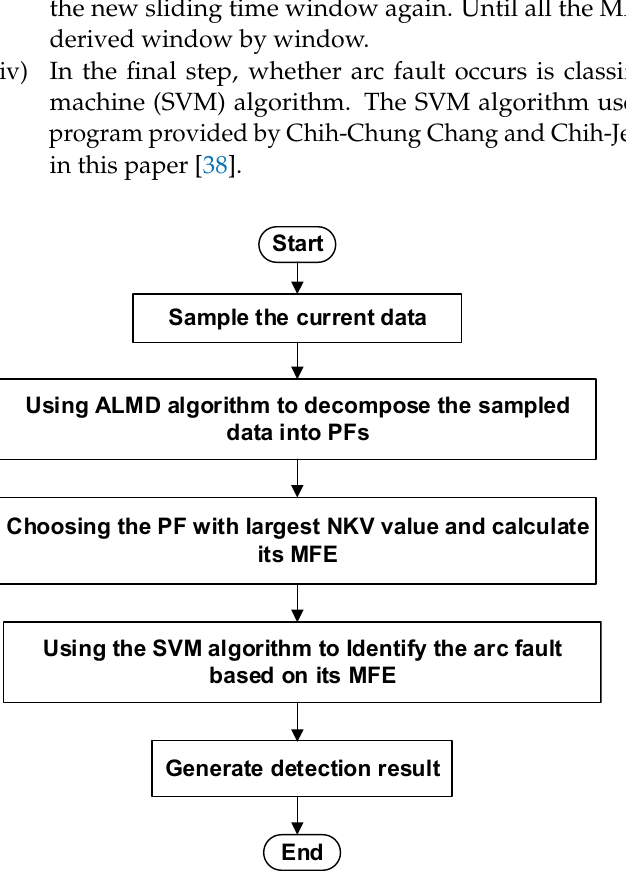
Figure 8. Block diagram of the procedures of the proposed arc fault detection method.